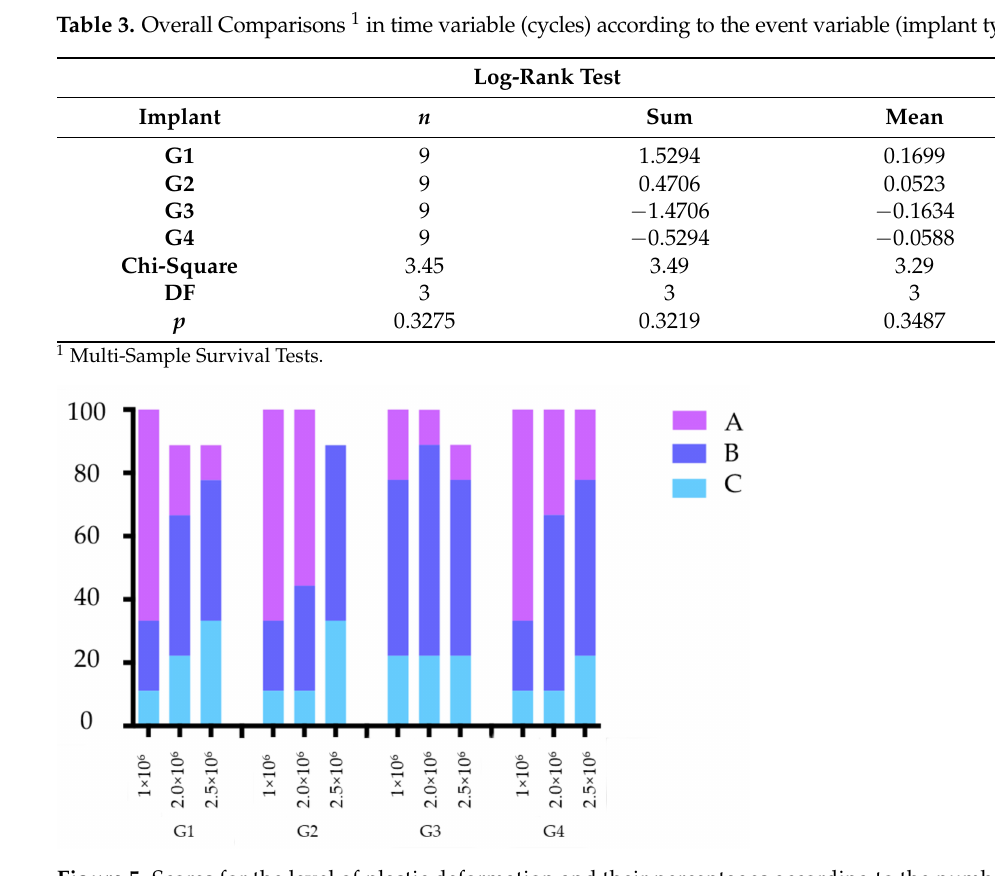
Figure 5. Scores for the level of plastic deformation and their percentages according to the number of cycles and implant types. Score A (no visible mark or plastic deformation), score B (slight Plastic deformation at one edge of the external hexagon), Score C (plastic deformation at all edges of the external